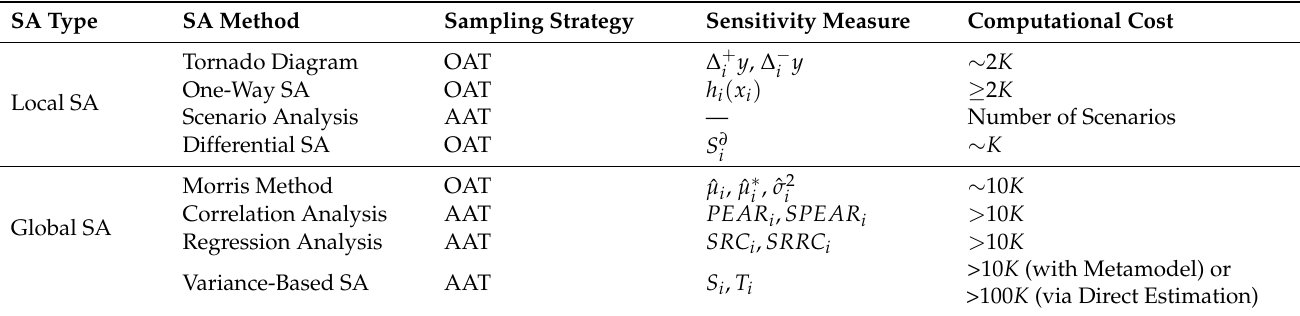
Table 1. Summary of the SA methods reviewed in Section 2 with the specification of the adopted sampling strategy (OAT or AAT) and the correspondent main sensitivity measure(s). A general indication of the approximate computational cost is also given in terms of model runs as a function of the model inputs’ number K , even if greatly dependent also on considerations such as model smoothness and analysis